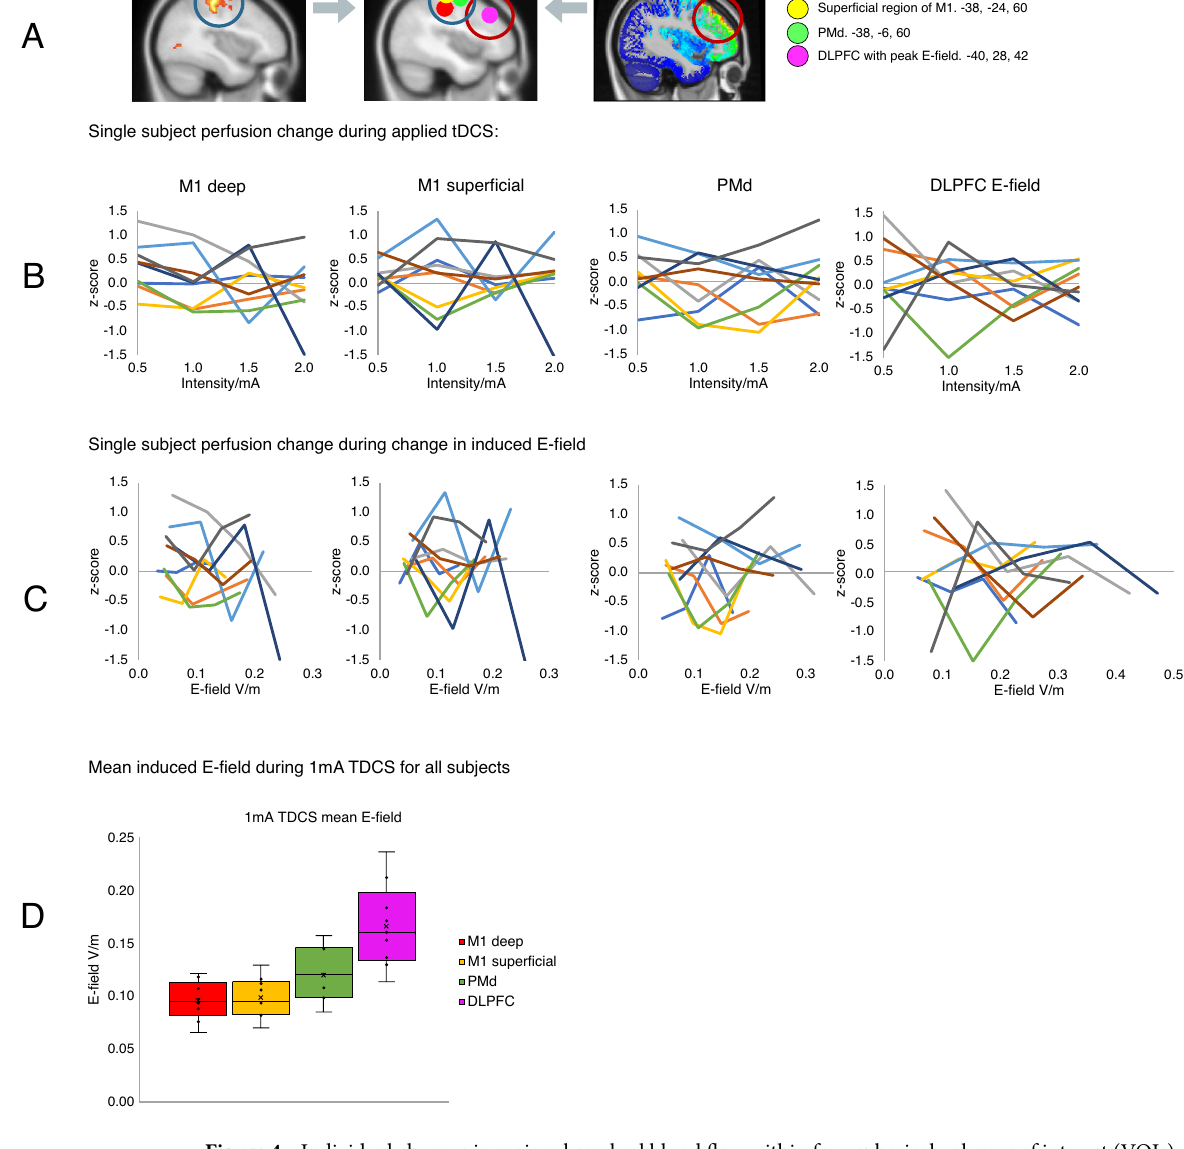
Figure 4. Individual changes in regional cerebral blood flow within four spherical volumes of interest (VOIs) with a radius of 10 mm. ( A ) The regional peak activations during finger-tapping prior to stimulation (FT-pre) was used as a functional localizer for the three spheres. Spheres were placed in the superficial primary motor cortex (M1) (yellow, center coordinate: − 38; − 24; 60) the deep part of M1 (red, center coordinate: − 38; − 24; 46) and the left dorsal premotor cortex (green, center coordinates − 38; − 6; 60). The fourth VOI (magenta) was placed at the location of maximum induced E-field in all subjects (center coordinate − 40; 28; 42). ( B ) Plots show individual activation within each VOI for each stimulation intensity. ( C ) Plots show individual activation within each VOI as a function of the induced E-field instead of TDCS intensity. ( D ) Boxplot of mean induced E-field in all four VOI’s at 1 mA TDCS. Y-axis shows induced E-field V/m. Outliers defined being beyond 1.5 inter-quartile range of each